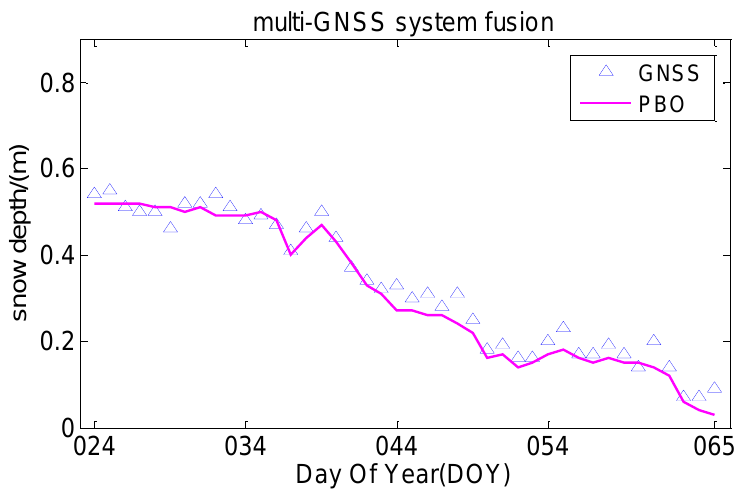
Figure 13. Mean fusion retrieval results of multi-GNSS system.